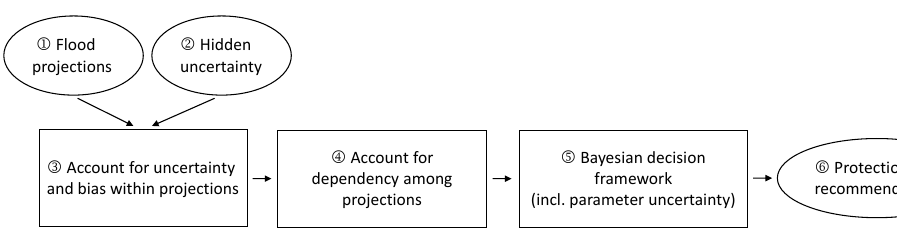
Figure 1. Process of finding the recommended planning margin from projections and hidden uncertainty estimate.